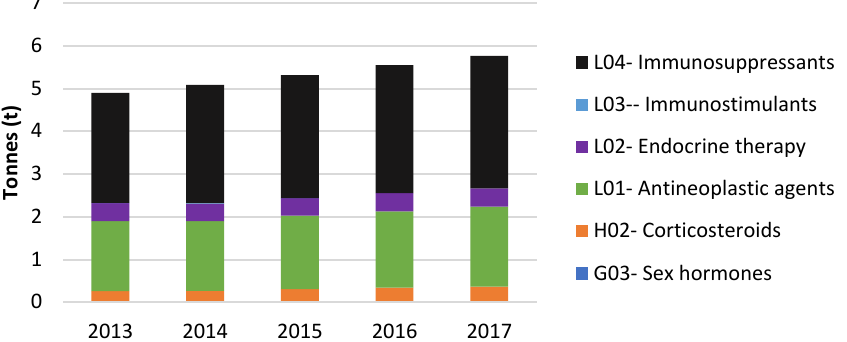
Figure 1. Annual consumption (in t) of cytostatic drugs in pharmacies and hospitals classified by the ATC code.